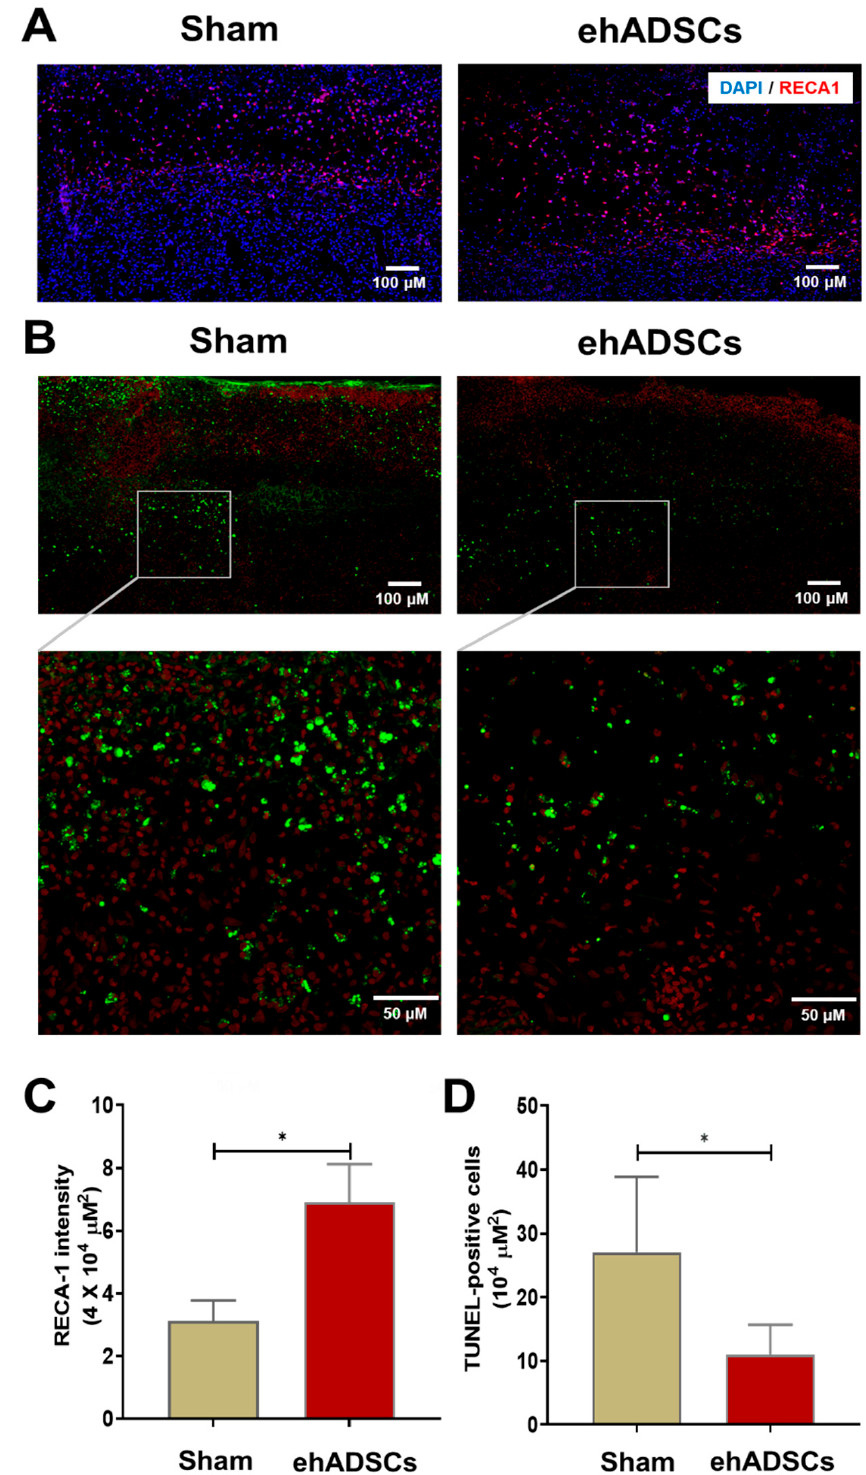
Figure 6. Epifluorescence analysis and TUNEL assay. ( A ) The ehADSC group exhibited greater RECA-1 staining intensity than the sham group on day 8. ( B ) The ehADSC group exhibited fewer TUNEL-positive cells than the sham group on day 8. ( C ) RECA-1 staining intensity in the wound area was significantly greater in the ehADSC group than in the sham group. ( D ) The number of TUNEL-positive cells in deep soft tissue was significantly lower in the ehADSC group than in the sham group (* p < 0.05).